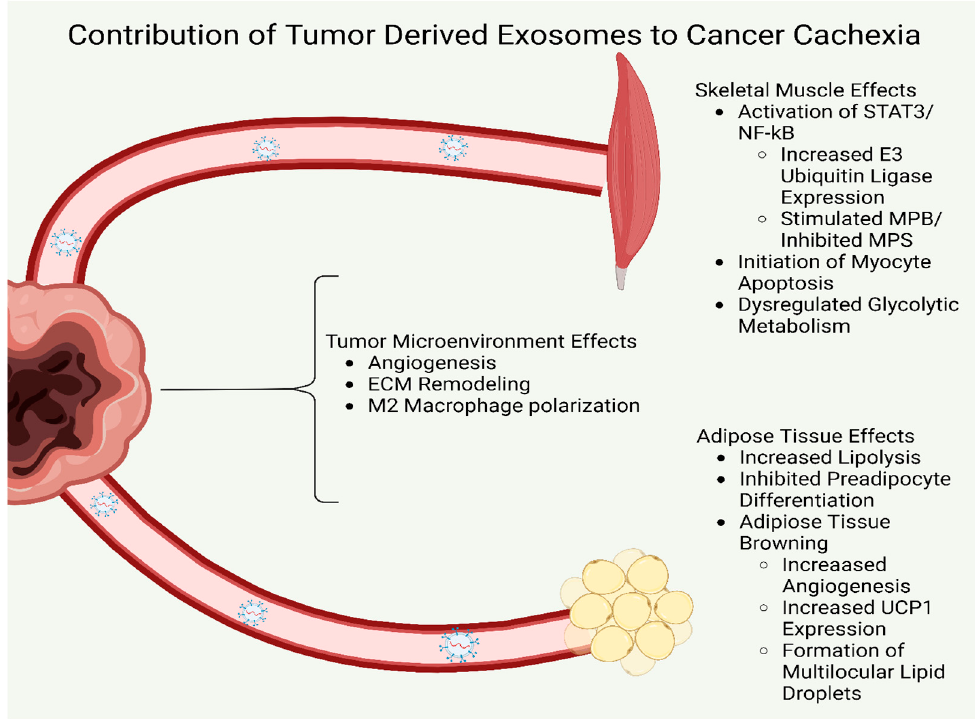
Figure 2. Exosome regulation of muscle and adipose wasting in cancer cachexia. Tumor cells secrete a range of exosomes which differ based on the tumor type. Nevertheless, common features of exosomes include a tumor regulated inflammatory environment which stimulates cytokine and E3 ligase activation in skeletal muscle along with an upregulation of signaling for apoptosis, reduced myocyte protein synthesis, and increased muscle protein degradation. Furthermore, tumor derived exosomes stimulate a dysregulated metabolic phenotype in skeletal muscle. Similarly, tumor derived exosomes decrease adipogenesis, increase browning of adipose cells and increase lipolysis, which contributes to overall loss of adipose stores. The resultant loss of skeletal muscle and adipose tissue is defined as cancer cachexia.